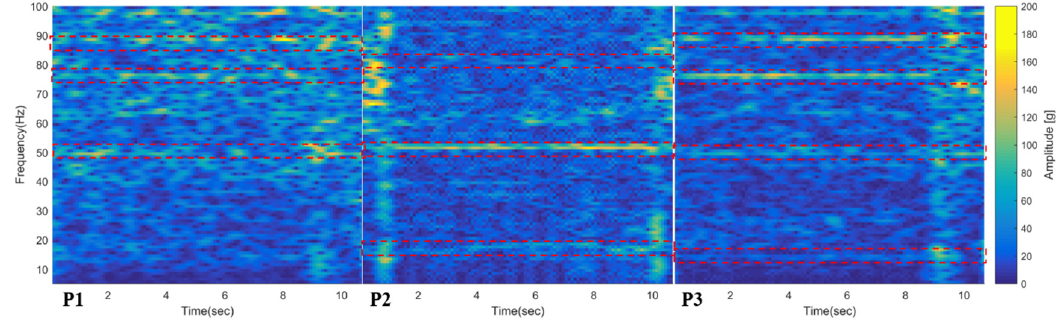
Figure 14. short-time fourier transform (STFT) of vibration signals of P1–P3.